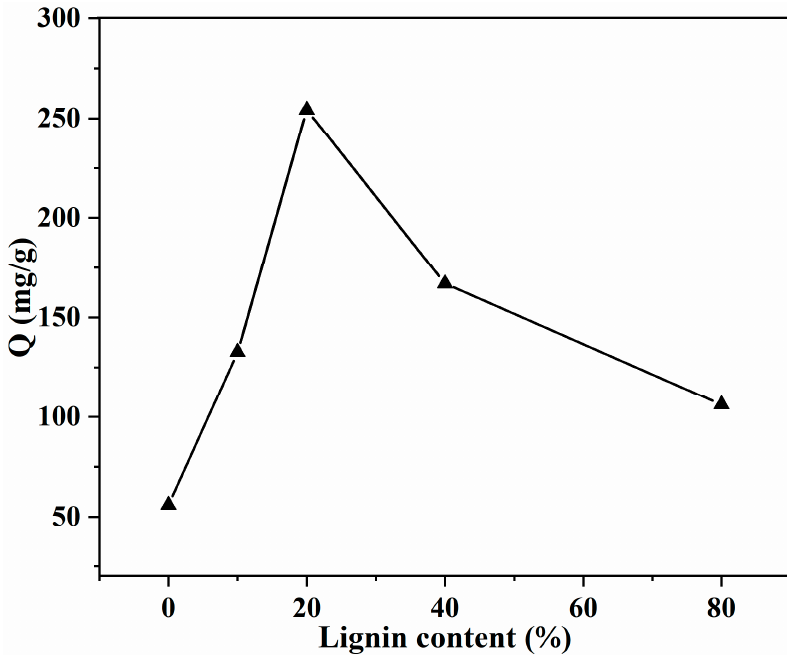
Figure 4. Effect of Lignin content on the adsorption capacity ( m = 20 mg, C 0 = 200 mg/L, V = 30 mL, pH = 7, T = 25 °C, s = 150 r/min, t = 24 h).